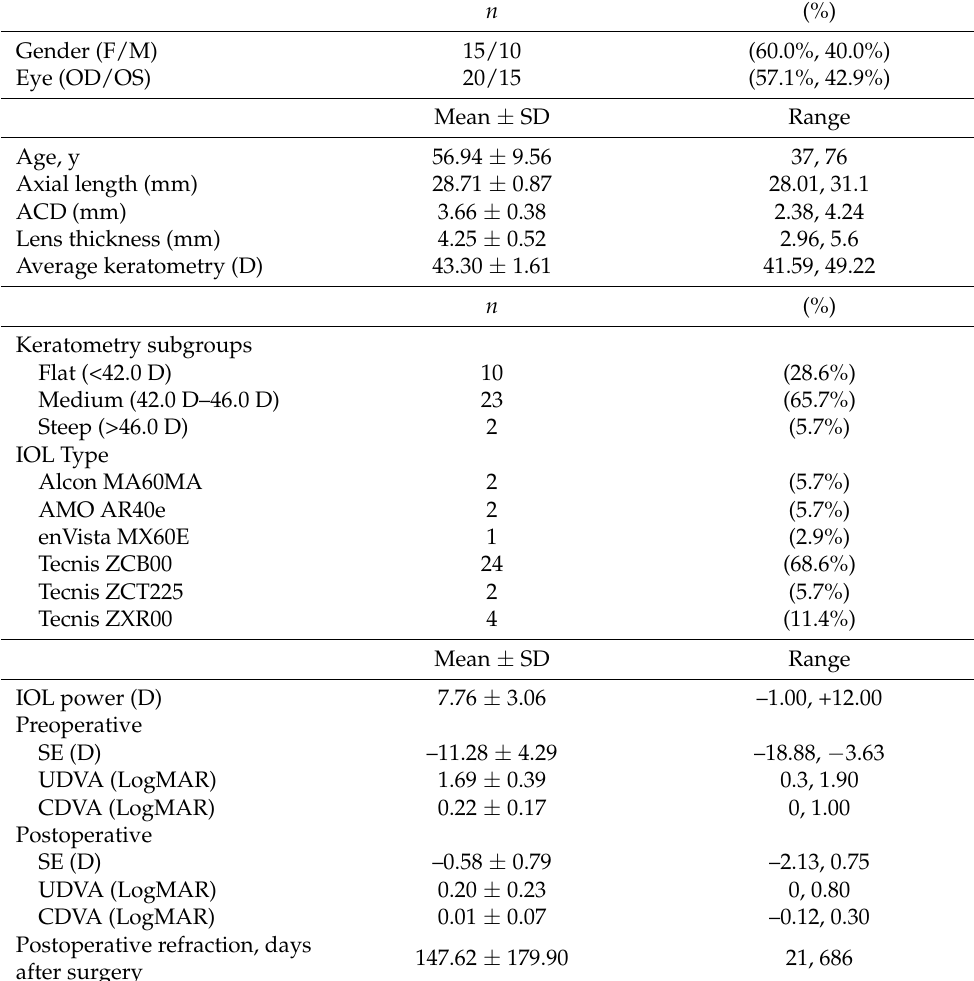
Table 1. Demographics, biometrics, and refractive outcomes ( n =